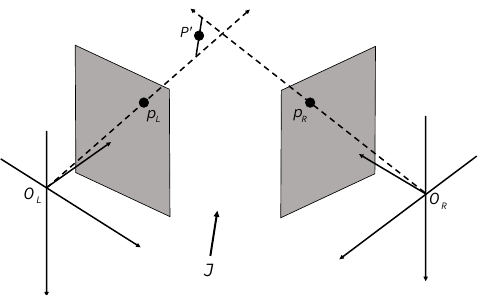
Figure 4. Target altitude estimation